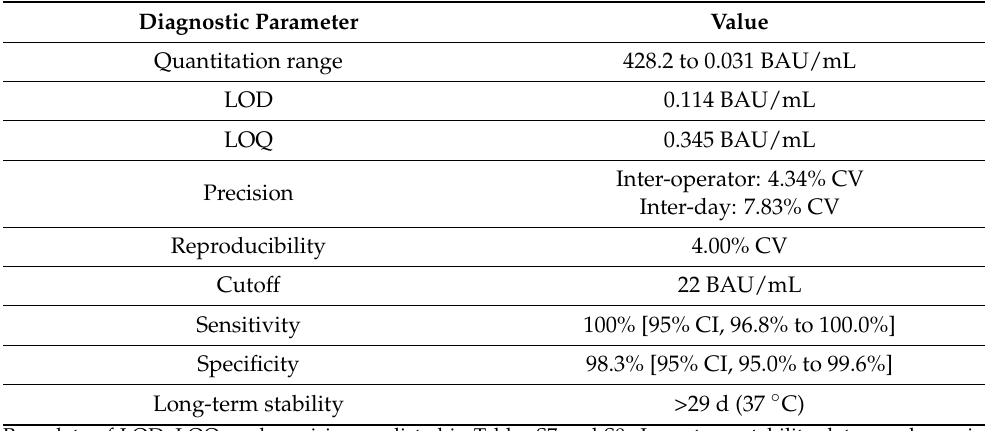
Table 1. Diagnostic parameters of the indirect S-IgG